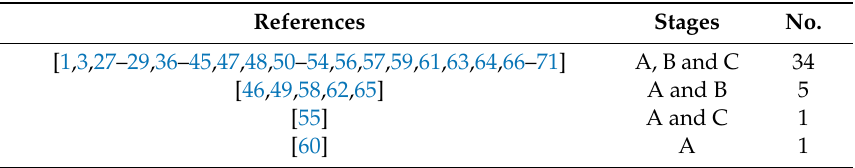
Table 5. Articles according to the three stages of the